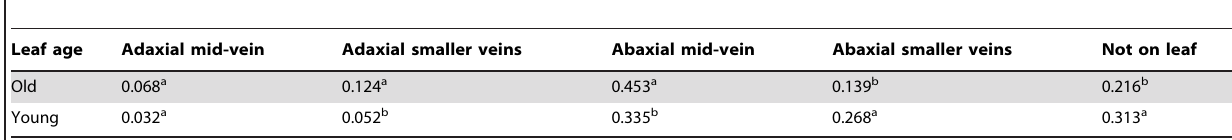
Table 2. Proportions of D. citri adults, per-settling site, on old and young leaves of x Citroncirus plants based on the chosen model (no. 3 in Table 1) that indicated that differences in settling patterns were only associated with the age of the leaf (Expt. 1a).